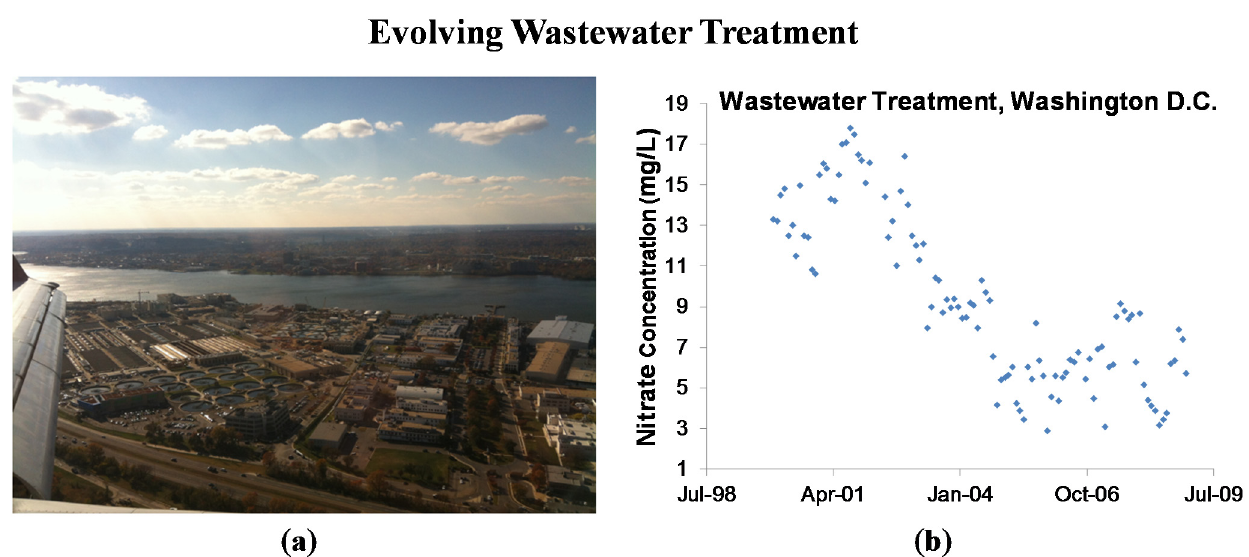
Figure 1. Blue Plains is among the largest advanced wastewater treatment plants in the world, and it treats sewage from Washington, DC, USA (Photo Courtesy: S. Kaushal) ( a ); Blue Plains discharges treated effluent to the Potomac River. There has been a long-term decline in nitrate concentrations in wastewater effluent as denitrification technology has improved over time ( b ) (Data courtesy of Dr. Sudhir Murthy and Blue